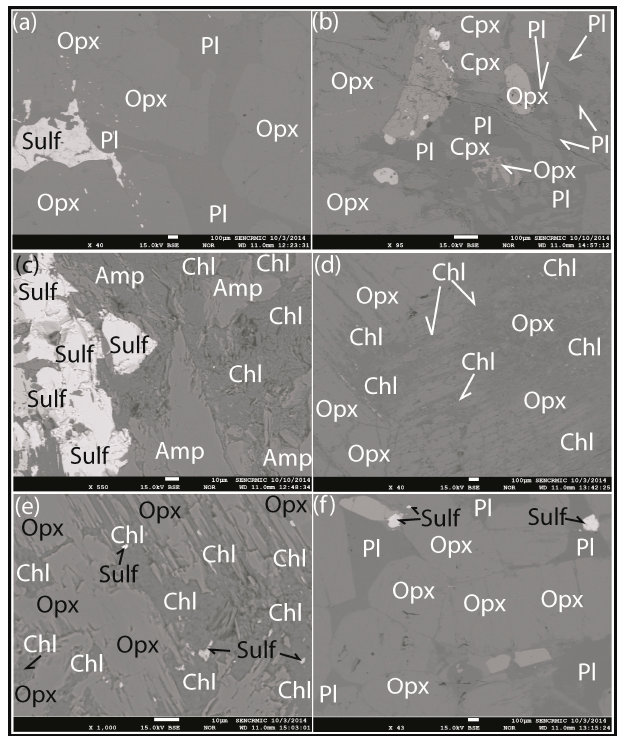
Figure 9. ( a ) Coarse-grained (>2 cm in size) sulfides occur in association with coarse-grained orthopyroxene (Opx) crystals which contains inclusions of very fine-grained sulfides (Sulf) (sample MusPxHw01). Notice that the cumulus plagioclase (Pl) is almost free of such fine-grained sulfide inclusions ( a ). ( b ) A narrow band of pegmatitic plagioclase pyroxenite contains cumulus orthopyroxene (displaying the typical orthopyroxene cross-section) and plagioclase (sample MusPeg01). ( c ) Abundant relatively coarse-grained sulfides in the base metal sulfide zone which occurs close occurring in association with alteration phases of chlorite (Chl) and amphibole (Amp) (sample MusBMSZ01). ( d ) Chlorite occurring as a common alteration phase in association with orthopyroxene (sample IRUP01). Note laths of sulfides also occur in association with the chlorite ( d ). ( e ) Sulfide inclusions occurring within the cumulus orthopyroxene crystals with chlorite occurring in association with numerous and elongated sulfide crystals (sample MusPxaFwt01). ( f ) Cumulus orthopyroxene, intercumulus plagioclase, together sulfides which occur either as intercumulus phases or as inclusions in both orthopyroxene and plagioclase (sample MusPxbFwt01).